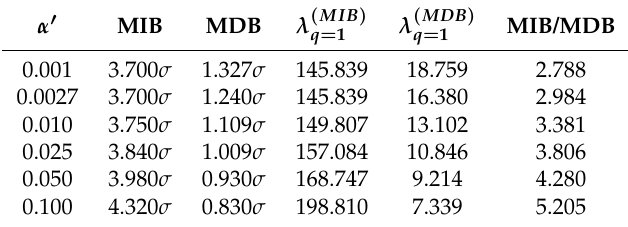
Table 8. Relationship between the MDB and MIB for ∆ h 1 and for ˜ P CD = ˜ P CI = 80%.